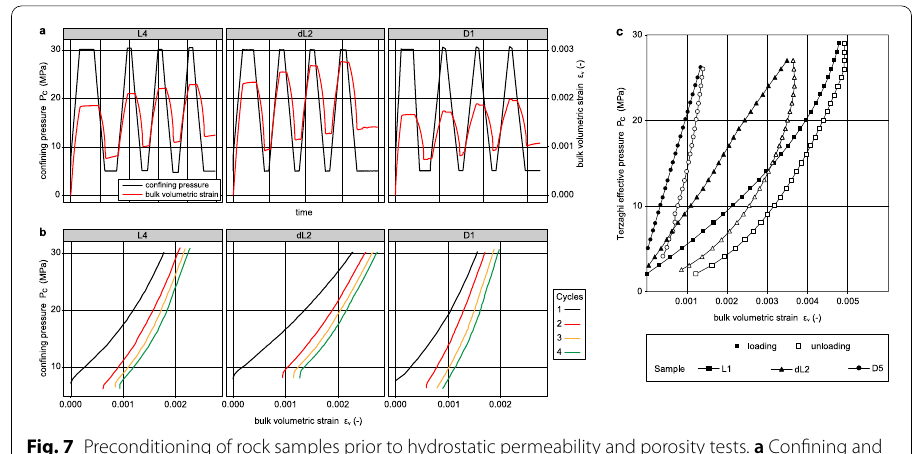
Fig. 7 Preconditioning of rock samples prior to hydrostatic permeability and porosity tests. a Confining and axial pressure were cycled simultaneously four times between 5 and 30 MPa to reduce inelastic behavior and to close microcracks. The bulk volumetric strain curves show irreversible deformation and relaxation hysteresis during unloading. b Each loading/unloading cycle during preconditioning increases the linearity of the stress–strain curves, indicating increasing elasticity. c Evolution of bulk volumetric strain during hydrostatic stress as a function of Terzaghi effective stress. The gap between loading and unloading indicates creep deformation. A nonlinear relaxation with a hysteresis is clearly visible with the onset of the unloading phase and an irreversible deformation at the end of the test